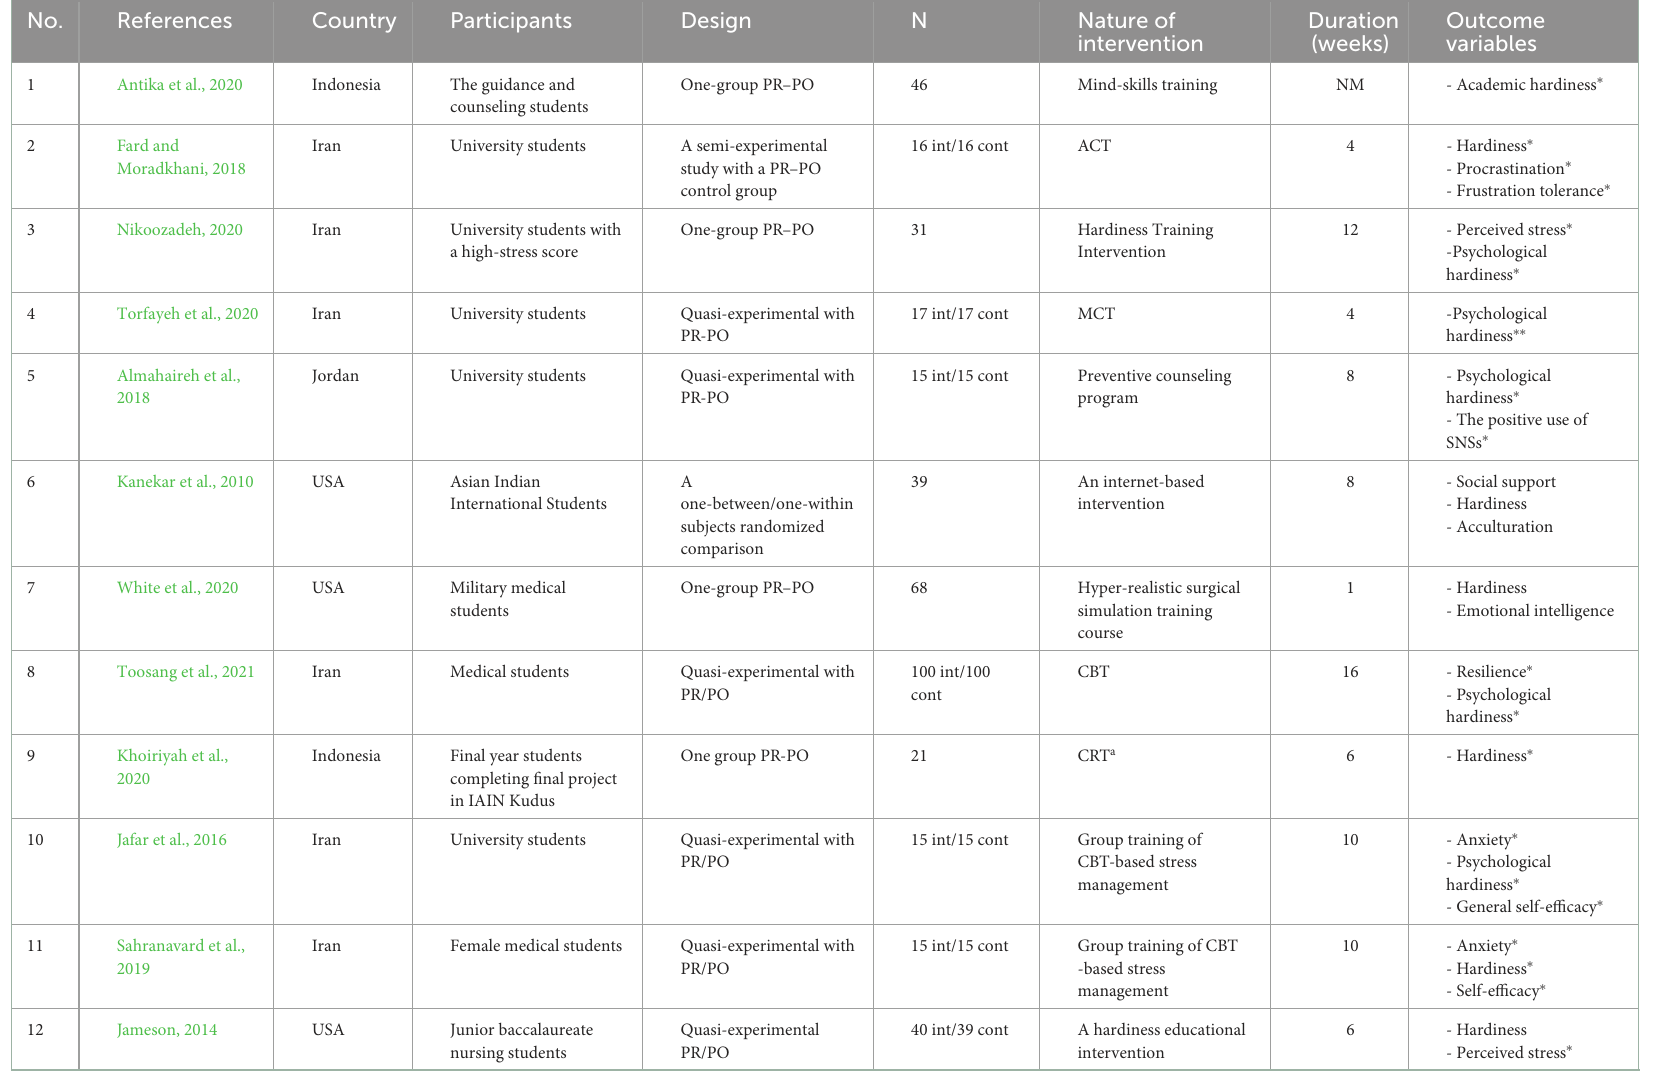
TABLE 1 Intervention characteristics of the included studies.